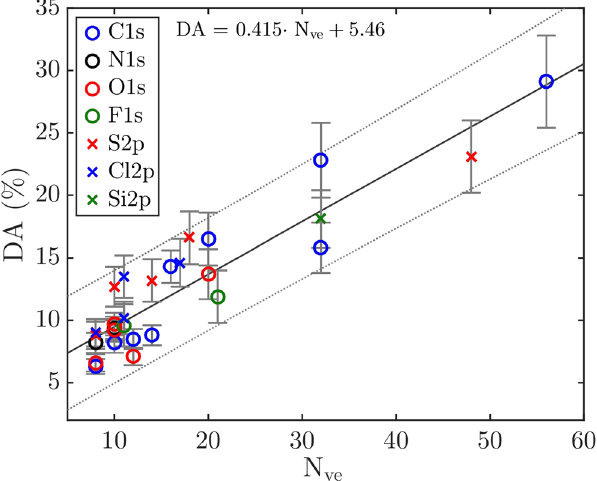
Figure 2. Percentage of double Auger as a function of the closest neighbouring valence electrons. The linear fit (solid line) show the trend among the molecules in Table 1, with a 95% confidence interval (dotted line) for the fit. The standard error in each data point is displayed as an error